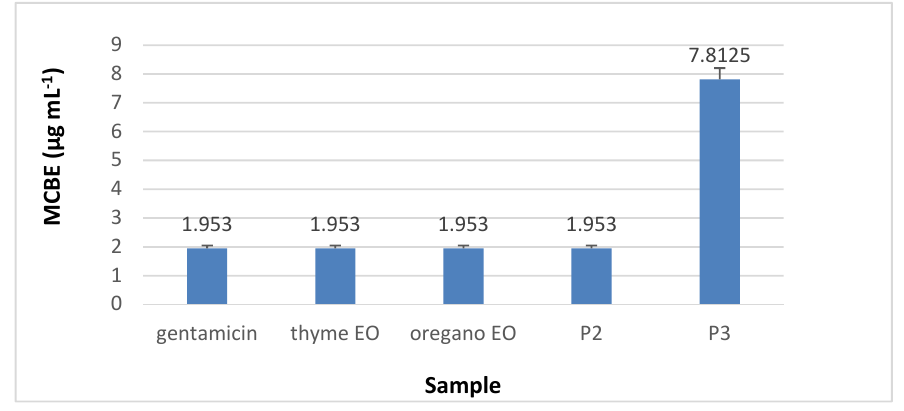
Figure 16. MCBE of collagen nanofibres loaded with essential oils against P. aeruginosa ATCC 27853, as compared to gentamicin and essential oils.